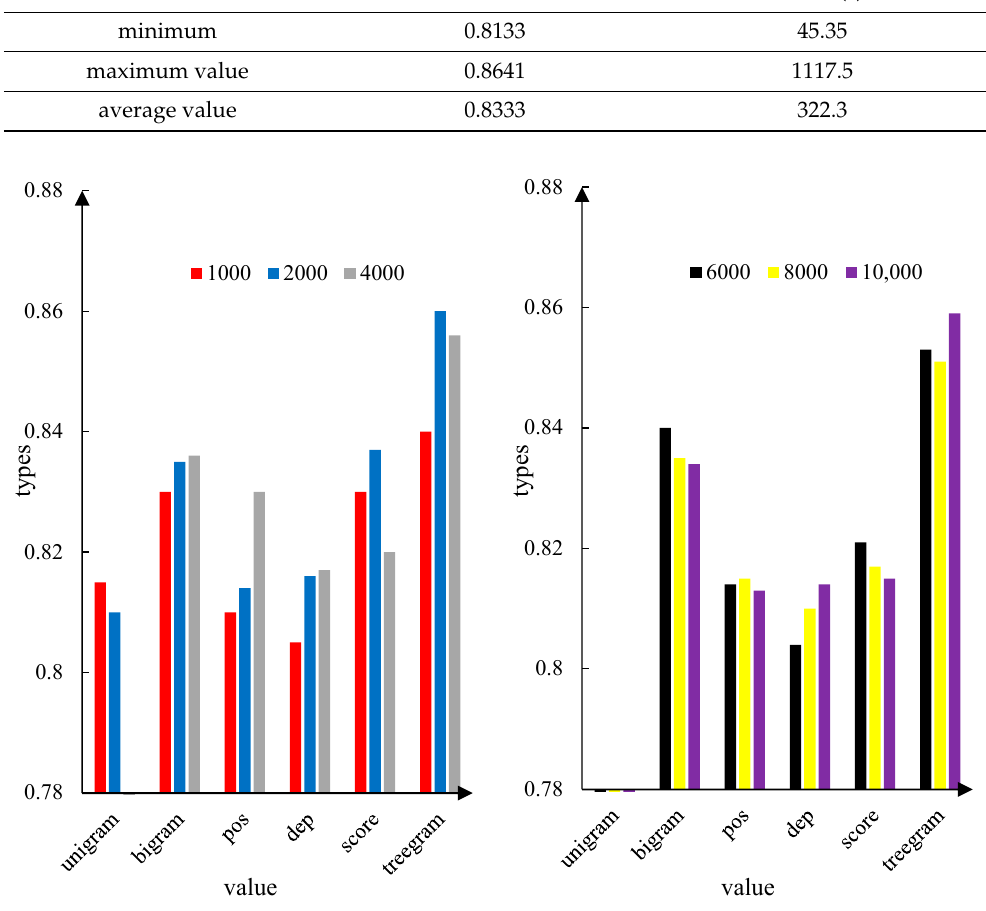
Figure 5. DBN: X20000-1000-500-200-100 classification standard rate. The minimum, maximum, and mean values of the source data results were calcu- lated. Statistical results are presented in Tables 3–6. Table 3. DBN: X2000-1000-500-200-100 statistical results.